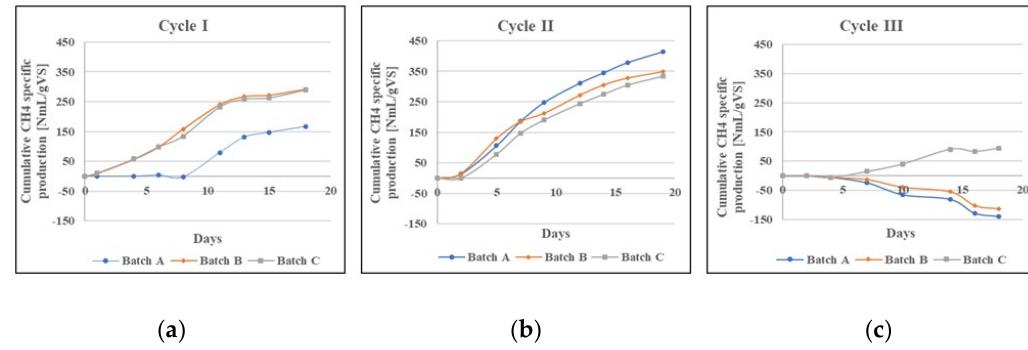
Figure 2. Specific cumulated biomethane production from three cycles of batch tests (( a ) – cycle I; ( b ) – cycle II; ( c ) – cycle III). Each cycle was conducted in triplicate at T = 35 ± 0.5 ◦ C and with a substrate-to-inoculum ratio of